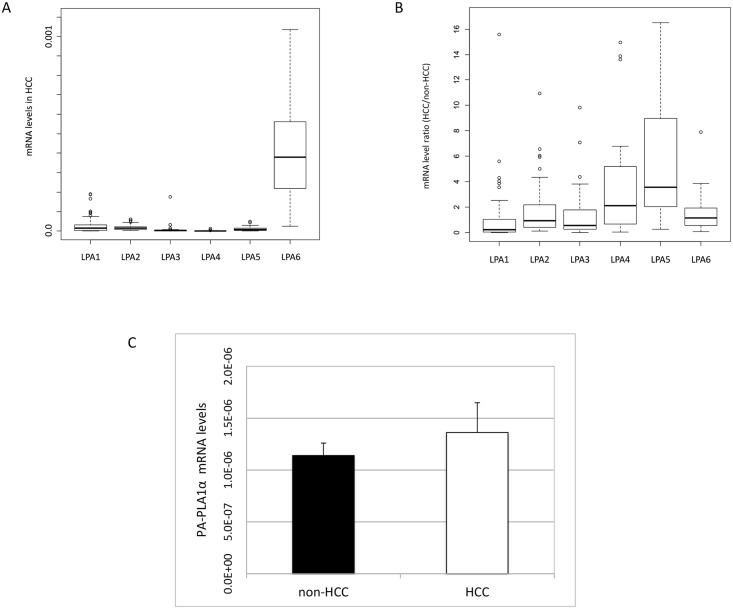
The mRNA expression levels of the LPA receptor and PA-PLA1ɑ, LPA-generating enzyme other than ATX, in HCC.(a) mRNA levels of LPA receptors in HCC tissue. (b) The ratio of mRNA levels of LPA receptors between HCC and adjacent non-HCC tissue. (c) mRNA levels of PA-PLA1ɑ in HCC and adjacent non-HCC tissue.